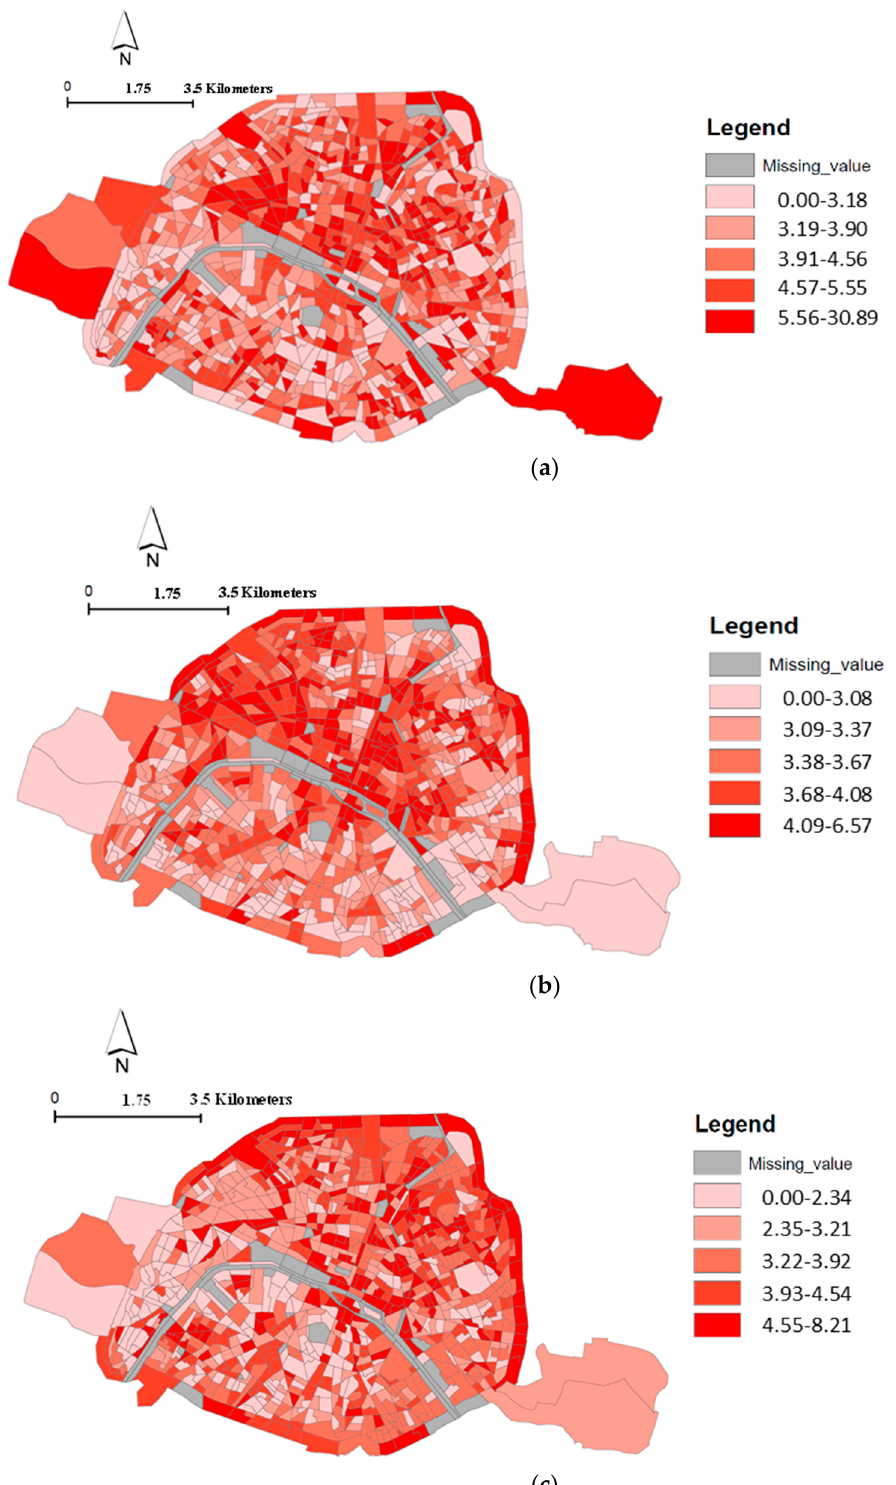
Figure A4. Spatial distribution of the rate of deaths attributable to PM 10 among total death, at the census block level, Paris City; ( a ) without spatial variability of PM 10 exposure in Paris; ( b ) with spatial variability of PM 10 between census block; ( c ) with spatial variability of PM 10 and socio-economic level between census block.